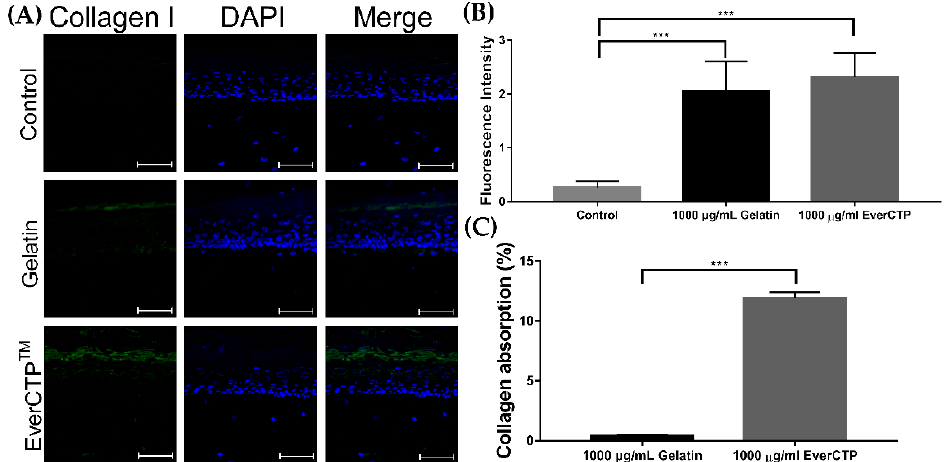
Figure 10. Comparison of collagen 1 expression using immunofluorescence staining ( A ). The 1000 µ g/mL gelatin (nonhydrolyzed collagen) treatment collagen induced more collagen 1 expression than the control ( B ). The 1000 μ g/mL EverCTP TM treatment induced more collagen 1 expression than the 1000 μ g/mL gelatin treatment. Collagen absorption was considerably increased with 1000 μ g/mL of EverCTP TM compared to 1000 μ g/mL of gelatin ( C ); *** p < 0.005, independent samples t -test. Scale bar indicates 80 μ m.